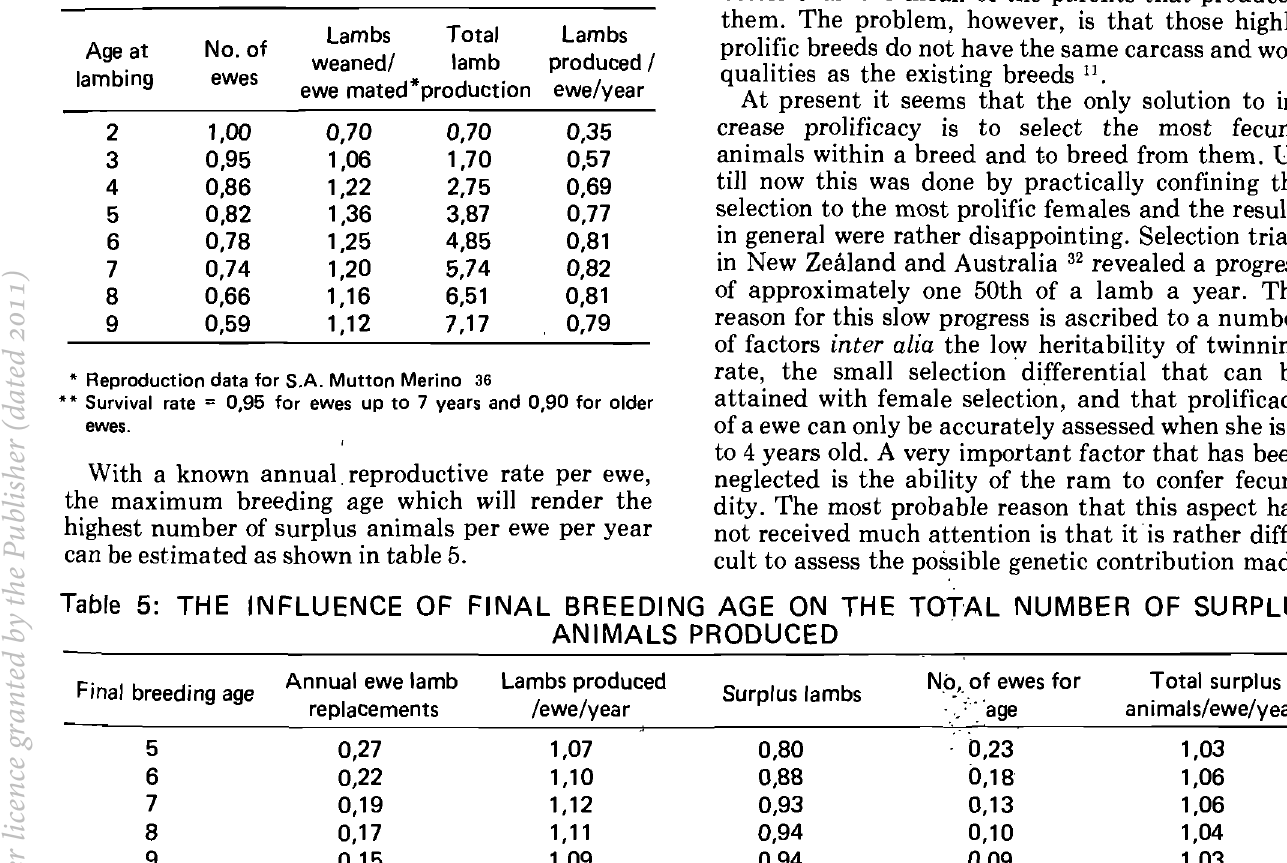
Table 4: ESTIMATED ANNUAL REPRODUC TIVE RATE PER EWE